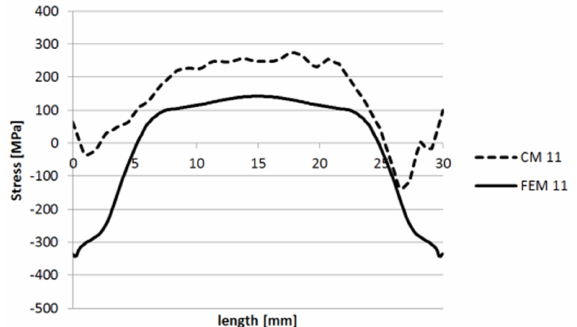
Figure 54. Stress levels in 11 direction along the CD line segment.